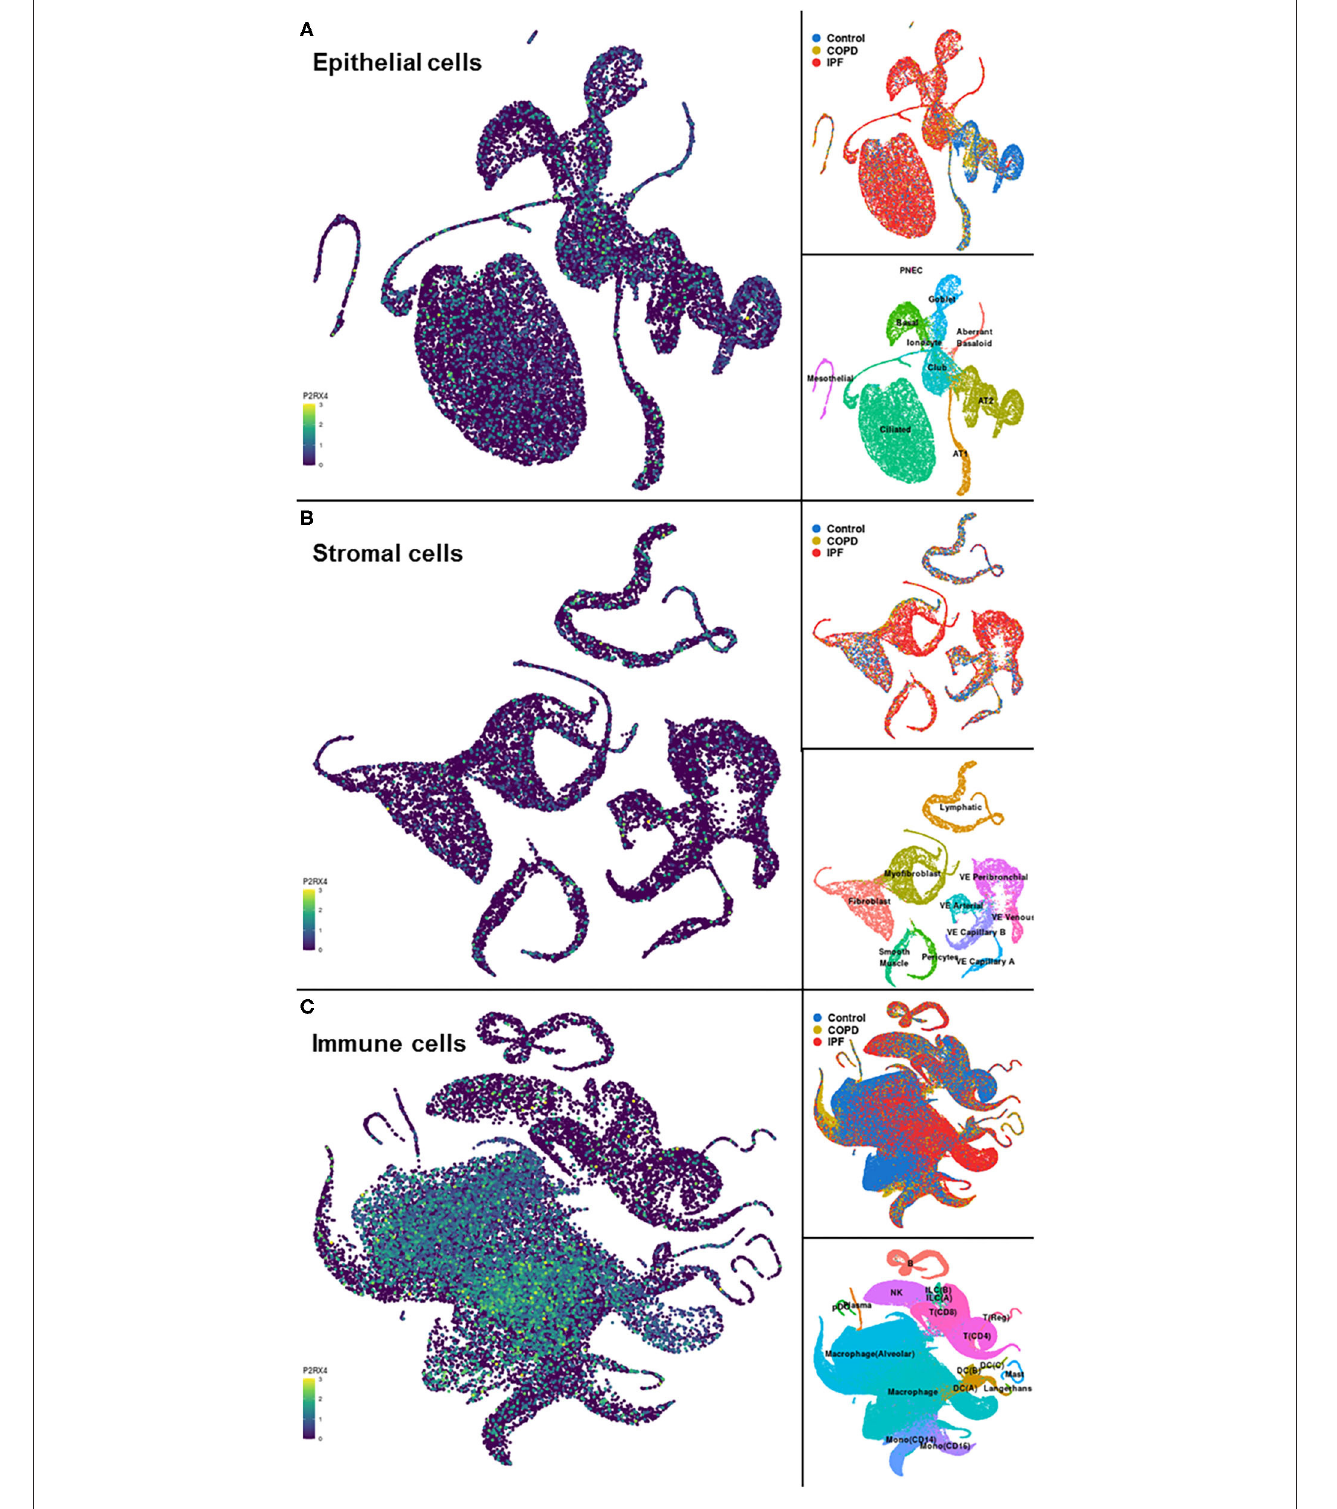
FIGURE 3 | Visualizations of cell type-specific distribution of P2RX4 expression within healthy and diseased lung tissue. Left-hand panels show Uniform Manifold Approximation and Projection (UMAP) plots of P2RX4 gene expression levels in epithelial (A) , stromal (B) , and immune (C) cell types, with lighter colors indicating higher expression. Upper and lower right-hand panels show disease state and cell type associated with each region of the corresponding UMAP plot, respectively. Data are n = 312,928 cells from 29 control, 18 chronic obstructive pulmonary disease (COPD) and 32 idiopathic pulmonary fibrosis (IPF) lungs. Images are from the “UMAP Explorer” tool in the IPF Cell Atlas using the Kaminski/Rosas dataset [https://p2med.shinyapps.io/IPFCellAtlas/, date first accessed: 22/04/2020 (30, 31)].